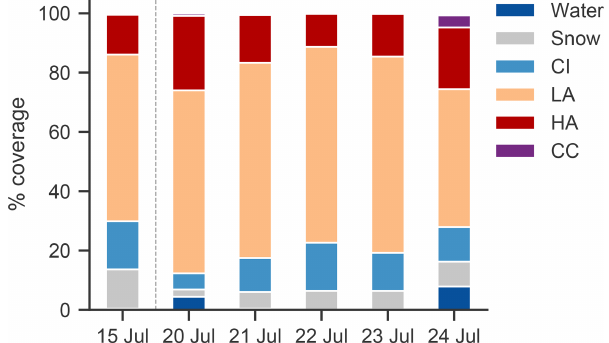
Figure 5. Percentage coverage of each surface type through time at S6.